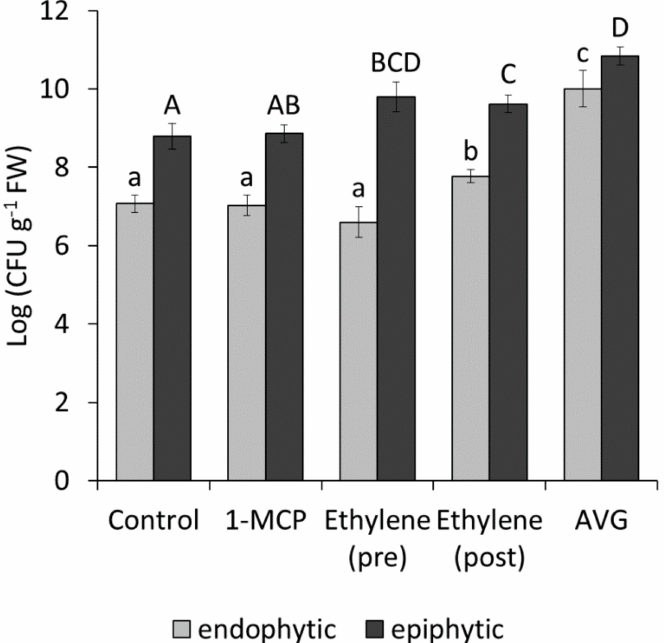
Figure 11. Effect of modulators of ethylene metabolim on bacterial colonisation. Endophytic and epiphytic populations of Pseudomonas syringae pv. actinidiae strain CFBP7286-GFPuv were